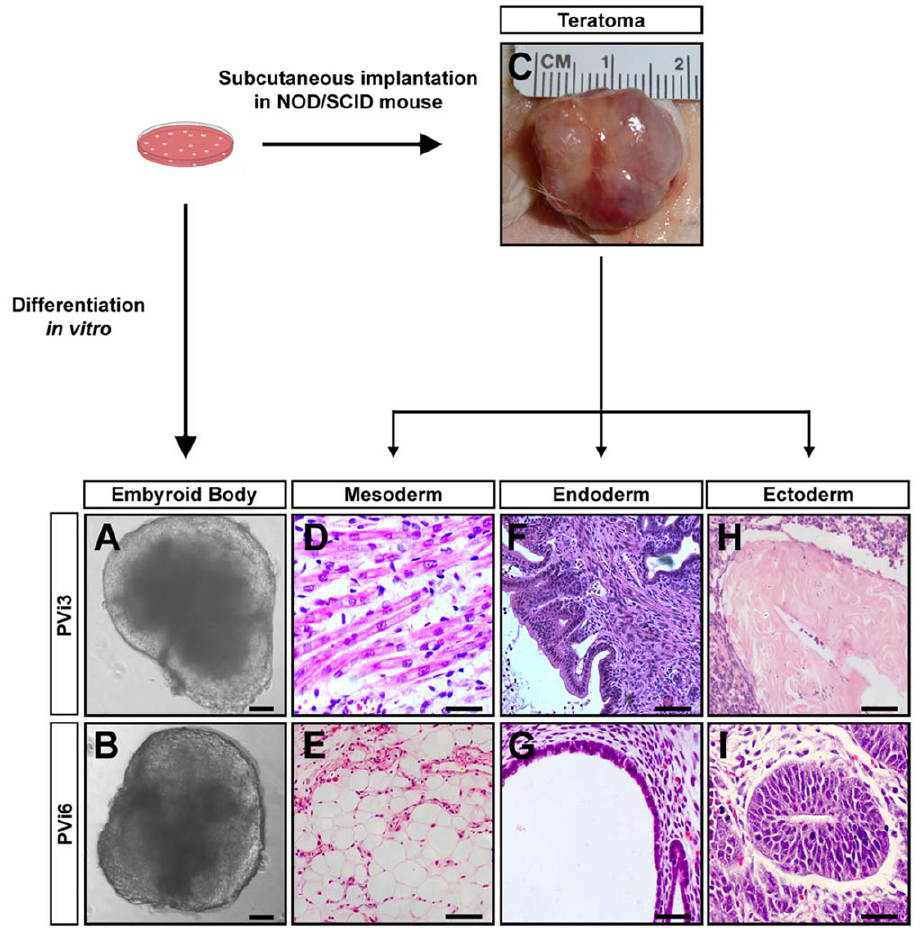
Figure 2. PVi lines are pluripotent in vitro and in vivo. ( A–B ) Differentiation of PVi lines in tissue culture yields embryoid bodies. ( C ) Teratoma obtained following subcutaneous implantation of PVi cells (PVi3) into a NOD/SCID mouse. ( D–I ) Hematoxylin and eosin stained tissue from teratomas obtained from PVi3 (D, F, H) and PVi6 (E, G, I) shows cellular differentiation into mesodermal, endodermal, and ectodermal lineages. Scale bars equal 100 m m (A, B,